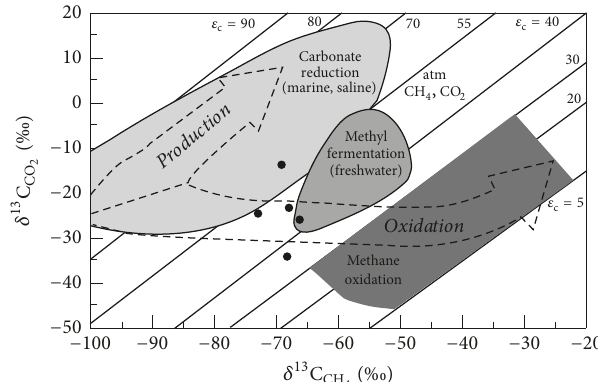
Figure 6: Diagram of carbon stable isotope composition of carbon dioxide versus methane for the study sites (modified after Whiticar,